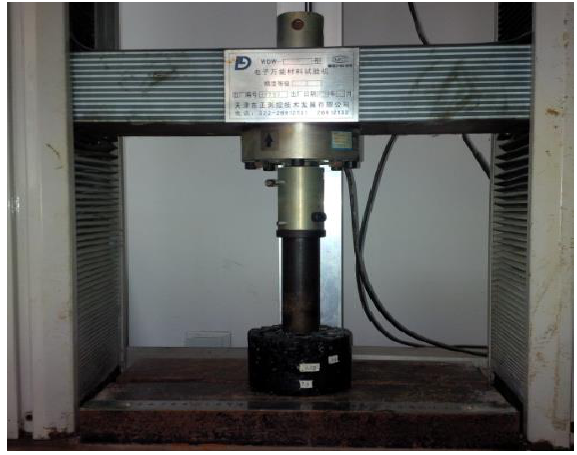
Figure 5. The electronic universal testing machine.